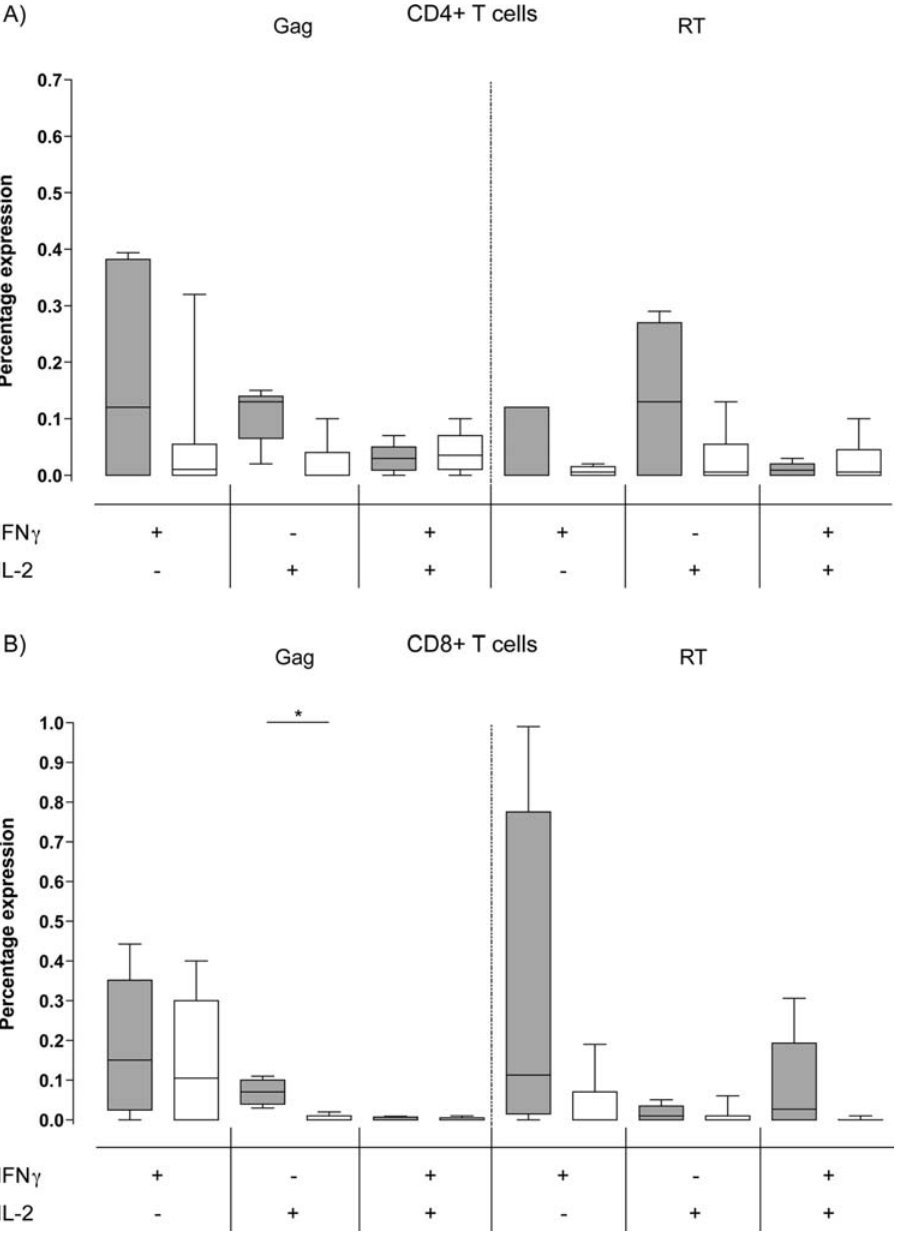
Figure 5. Exposure did not increase poly-functionality. The ability of CD8 + (A) and CD4 + (B) T cells to express IFN- c and IL-2 was assessed in both the VP group (shaded boxes, n=5) and NVP group (open boxes, n=8). Poly-functionality was determined by the expression of both cytokines. Only the percentage of IL-2 expressing CD8 + T cells was significantly higher in the VP group (p=0.0059), denoted by *.